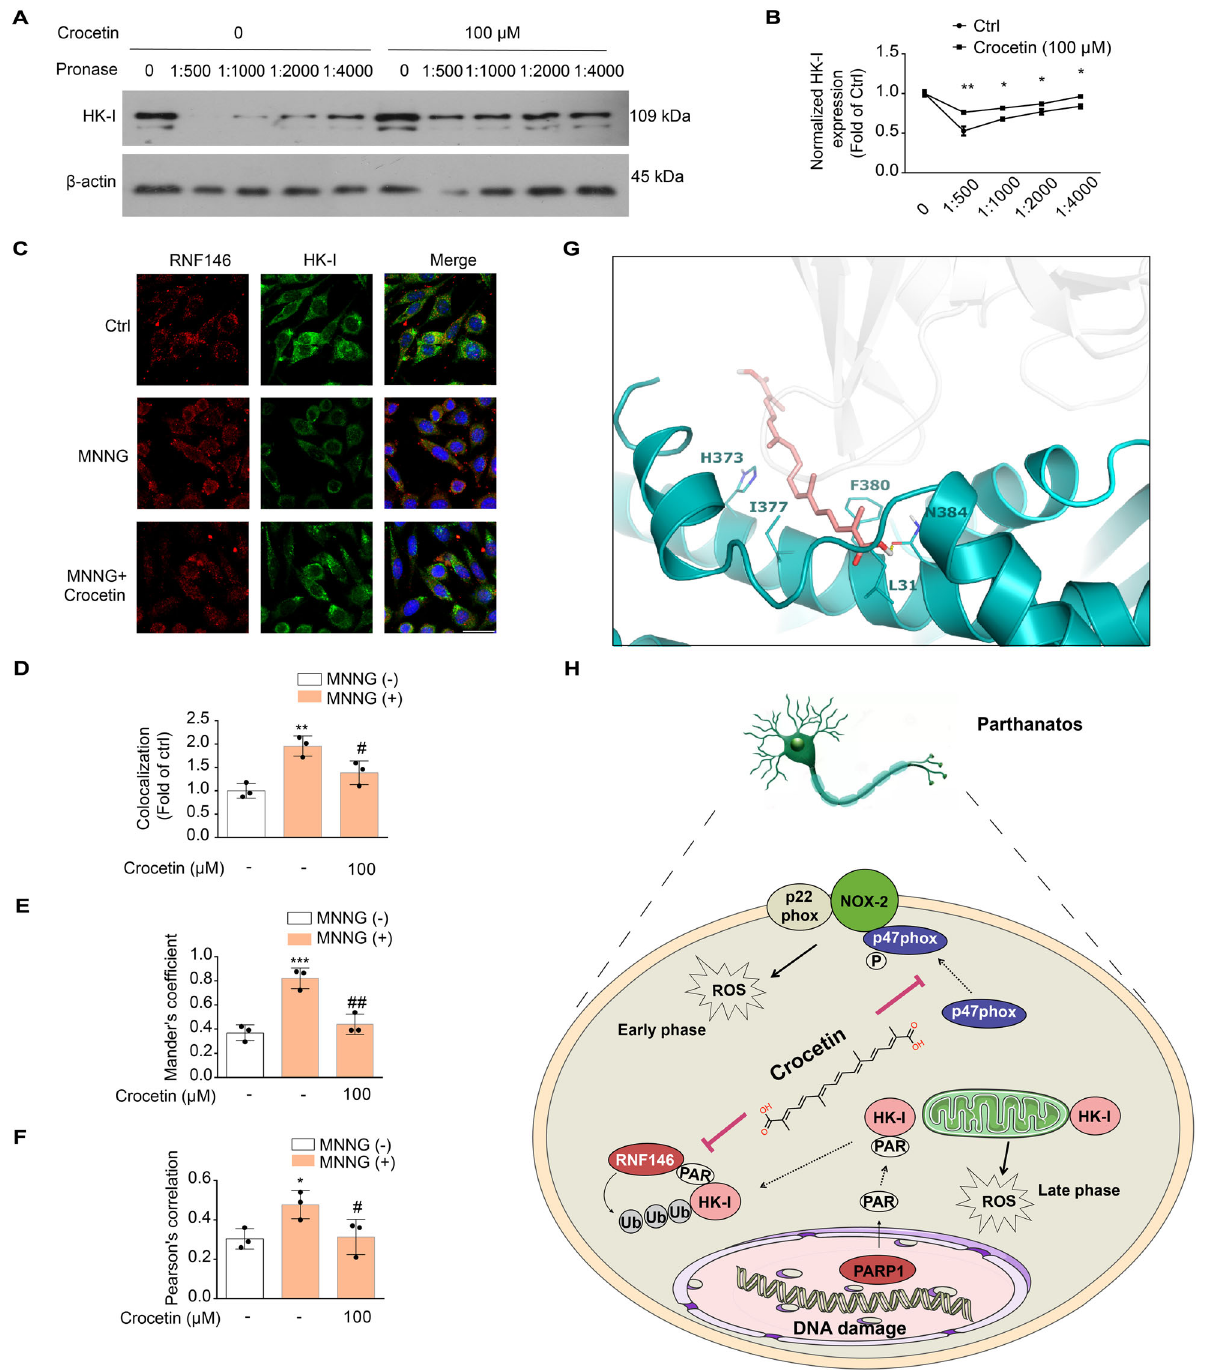
Fig. 8 Crocetin bound with HK-I and inhibited HK-I interaction with RNF146. A DARTS results from pronase-digested cell lysates. B Group quanti fi cation of HK-I in ( A ). Data represent the mean ± SD from three independent experiments. C Effect of crocetin on MNNG-induced interaction of RNF146 and HK-I by immuno fl uorescence assay with anti-HK-I (in green) and anti-RNF146 (in red); nuclei were stained with DAPI (blue). Scale bars: 10 μ m. D Colocalization between HK-I and RNF146 measured by Image J. E Mander ’ s coef fi cient between HK-I and mitochondria staining. F Pearson ’ s correlation coef fi cient between HK-I and mitochondria staining. G Docking analysis of the crocetin-HK-I complex. H The cellular pathways of crocetin to protect neurons from parthanatos and ischemic stroke. Signi fi cance was determined by one- way ANOVA. * p < 0.05, ** p < 0.01, *** p < 0.001, vs control group; # p < 0.05, ## p < 0.01 vs MNNG mitochondrial dysfunction. Thus antioxidants may be of particular only in male animals has limited their medical applications. Currently importance in preventing parthanatos as an IS treatment [11]. no PARP-1 inhibitors are in use for stroke treatment [46]. Based on the Recent studies have shown that NOX2 is the source for early phase crucial role of ROS in DNA damage, antioxidant agents such as ROS production and an upstream signal for PARP-1 in parthanatos propofol have been shown to prevent neuronal parthanatos through [10]. In line with this notion, we found MNNG induced rapid NOX2 reducing ROS-induced intracellular calcium release and attenuating